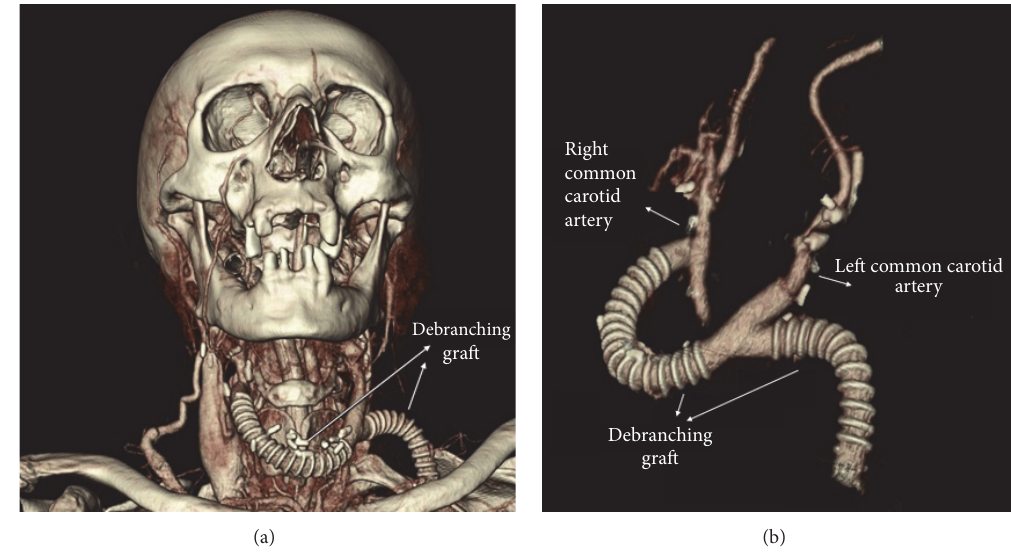
Figure 3: (a) Postoperative computed tomography (CT) angiography view of the debranching graft. (b) Debranching graft’s proximal anastomosis was performed end to side to right common carotid artery; graft’s carotid leg was anastomosed to left common carotid artery end to end; graft’s left subclavian artery leg was anastomosed to the left subclavian artery end to side; and left subclavian artery was simply ligated